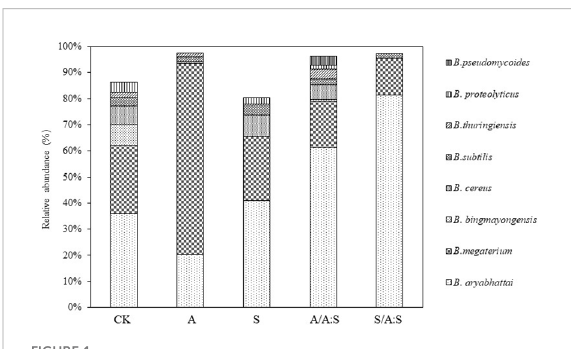
FIGURE 1 Relative abundance of Bacillus species in different treatments soil. C, control; A: Bacillus from the rhizosphere soil of A. artemisiifolia in the monoculture; S: Bacillus from the rhizosphere soil of A. artemisiifolia in the monoculture; A/A:S, Bacillus from the rhizosphere soil of A. artemisiifolia in the mixture; S/A:S, Bacillus from the rhizosphere soil of S. viridis in the mixture. Error bars represent ±SD of mean (n=3).